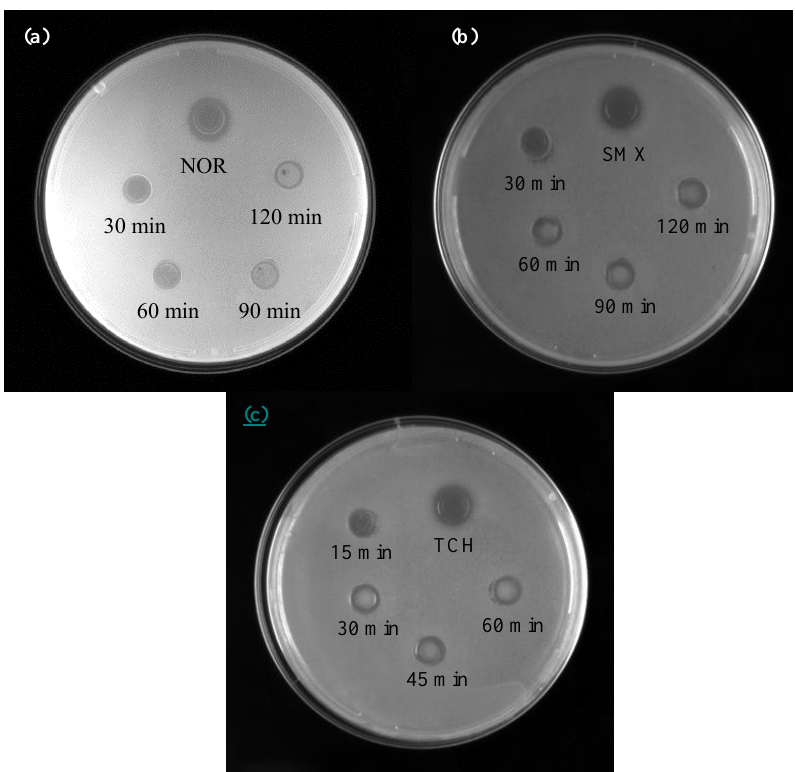
Figure 11. Antibacterial activities of NOR ( a ), SMX ( b ) and TCH ( c ) and their degradation products.